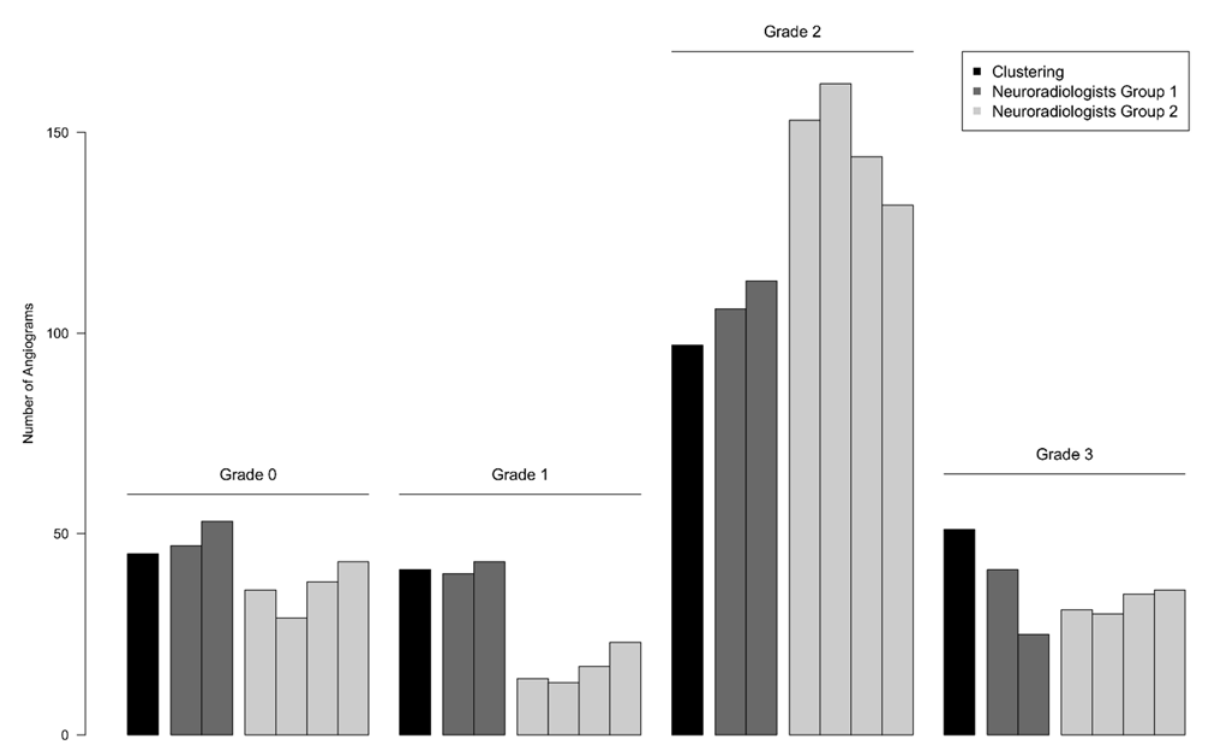
Figure 3. Reproducibility of visual classification of cerebral vasospasm. The mathematical clustering for objective comparison is depicted in black first, followed by the subjective grading of each rater labeled according to his profession. The first group in dark gray (two neuroradiologists) applied the primary visual cerebral vasospasm classification. The second group in light gray (four neuroradiolo- gists) applied the modified classification supplemented with the pM1 values. Neuroradiologists of the second group deviate more from the